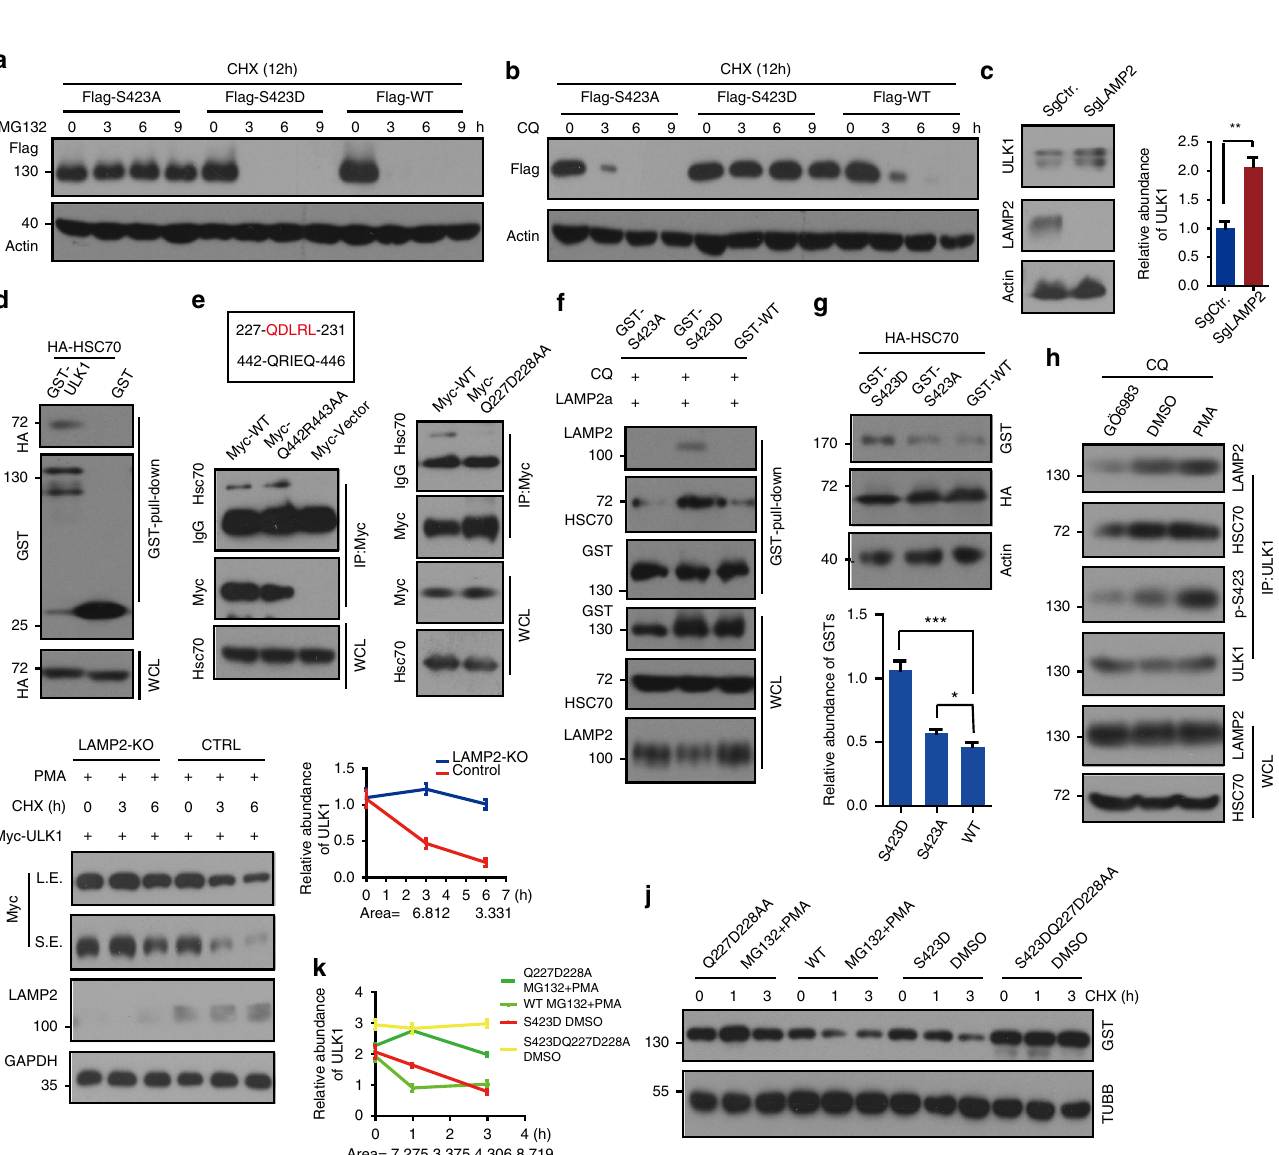
Fig. 6 Phosphorylation of ULK1 is degraded through chaperone-mediated autophagy. a MG132 (proteasome inhibitor, 20 μ m) prevents ULK1 S423A degradation but not degradation of ULK1 WT or S423D. Stable ULK1 WT and mutant HeLa cells were pretreated with cycloheximide (CHX, 20 μ g mL − 1 ), an inhibitor of protein synthesis, for 3 h. Then, the cells were treated with MG132 for a time course in the presence of CHX. The remaining ULK1 was detected by WB. b CQ inhibits ULK1 S423D degradation. The procedure is similar to Fig. 6a, but MG132 is replaced by CQ. c Accumulation of more ULK1 in Lamp2-KO cells. The abundance of ULK1 was quanti fi ed. d The interaction of ULK1 and HSC70 was determined by pull-down assay with overexpression of GST-ULK1 and HA-HSC70. e The HSC70 binding motif of ULK1 is between Q227 to L231, and the result was veri fi ed by double mutations and semi-endogenous co-IP assay by HSC70 antibody. f ULK1 S423D binds more HSC70 and LAMP2a than its counter partners. g Overexpression of HSC70 promotes ULK1 WT and S423Ds degradation, not S423A degradation. h PKC α activity increased the af fi nity of ULK1 to HSC70 and LAMP2. The results were detected with the indicated antibodies. WCL whole-cell lysate. i ULK1 degraded slowly in LAMP2-KO cells with PMA (a PKC activator) treatment. Myc-tagged ULK1 was transfected into the above two cell lines with the indicated drugs and time course. The remaining ULK1 was quanti fi ed. j Mutant ULK1 Q227D228AA prevents p-ULK1 degradation through the lysosome. k The quanti fi cation of Fig. 6j. All values are means± SEM of three independent experiments: * p < 0.05, ** p < 0.01, *** p < 0.001. WCL: whole-cell lysate, L.E.: long exposure, S.E.: short